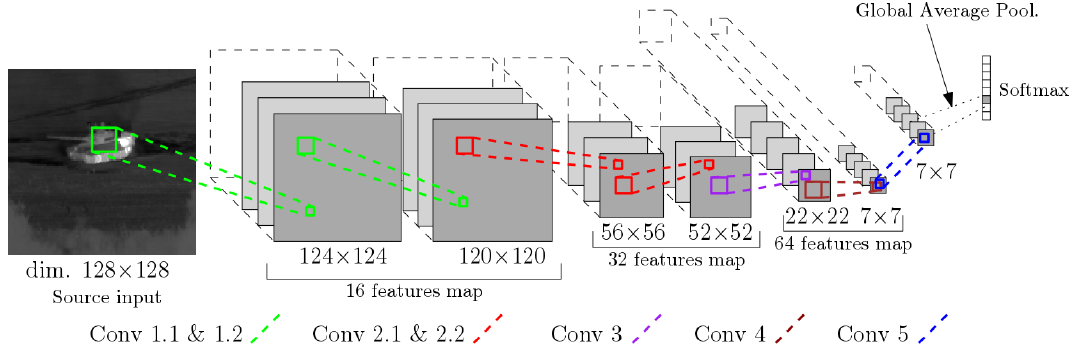
Figure 6. A compact and fully convolutional neural network used for infrared target recognition and identification. Table 1. Details of the proposed